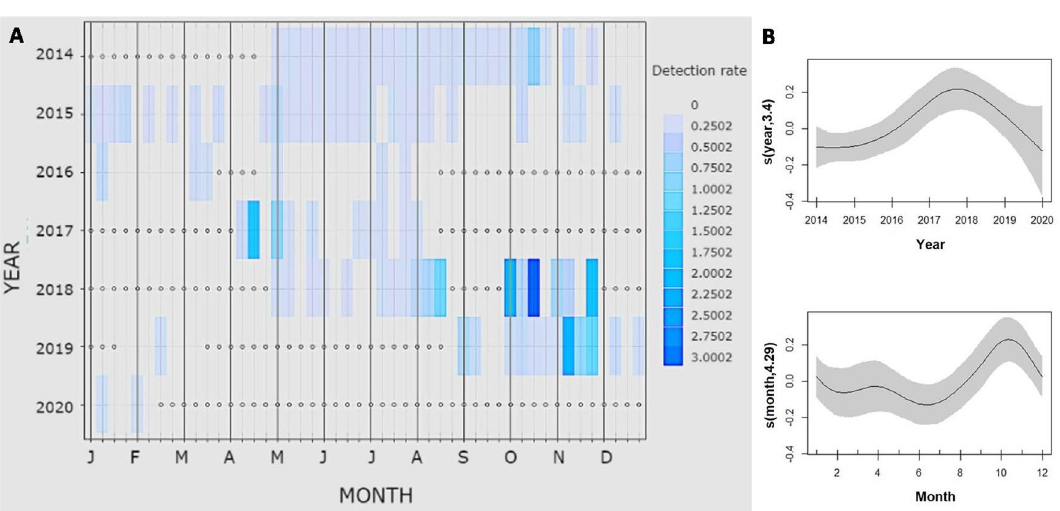
Figure 4. ( A ) Fin whale calls per week (detection rate) along the 7 years considered. White dots represent absence of data. ( B ) Response curves of the variables in the Generalized Additive Models (GAMs) performed testing DR as a function of the predictors Year and Month. The solid lines represent the smoothed estimates by the GAM, while the grey areas represent the approximate 95% confidence